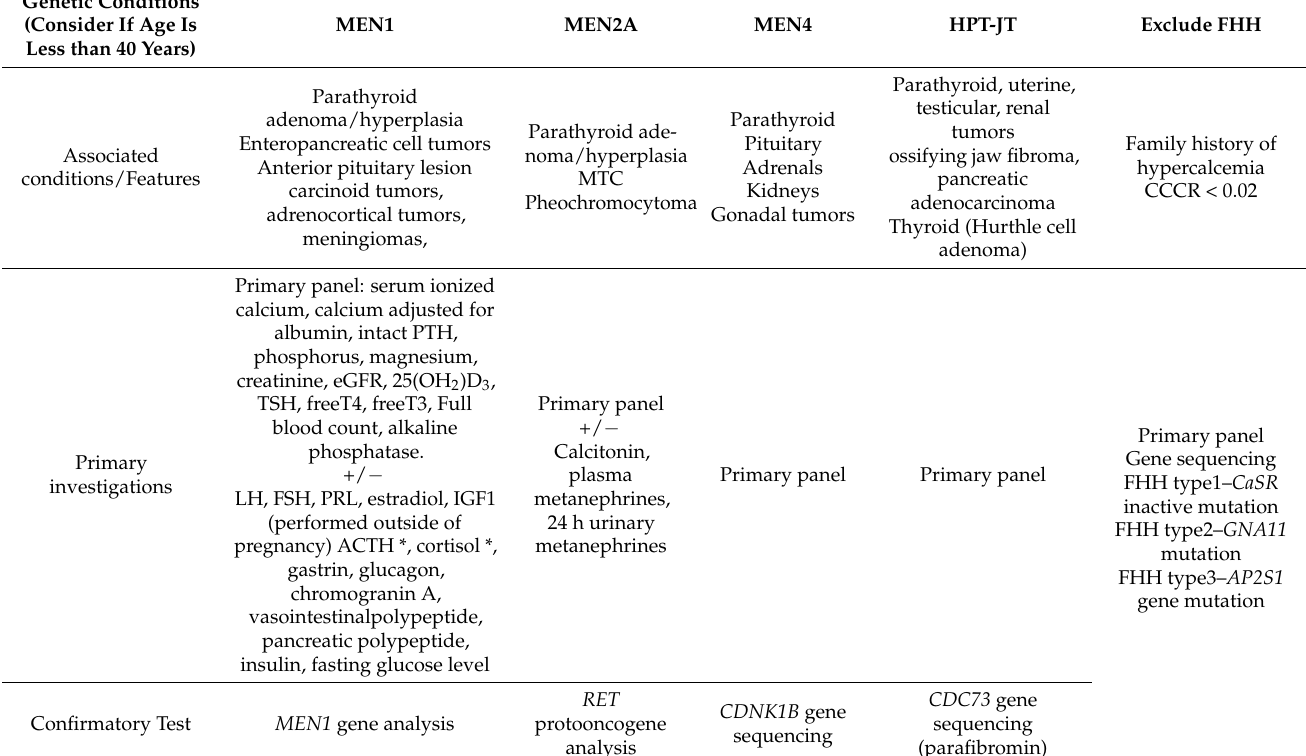
Table 1. Causes and Diagnostic Tools for